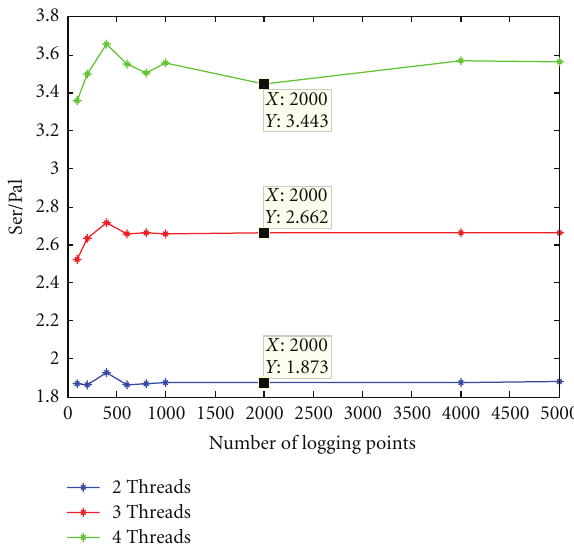
Figure 15: Comparison of H xx , H yy , and H zz (1000 points) from the serialized and parallelized codes.